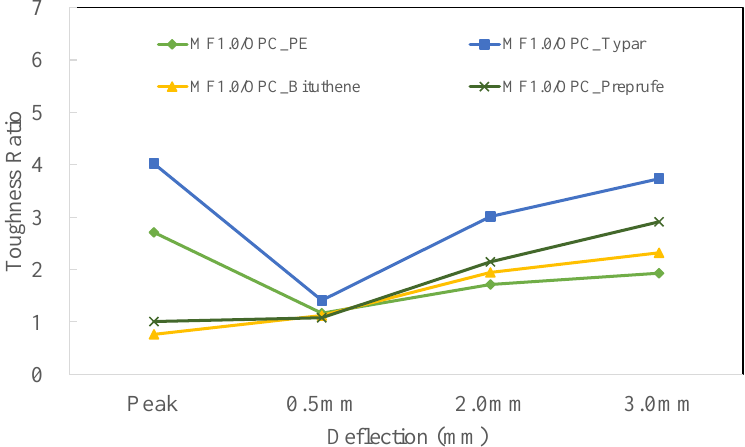
Figure 10. Toughness ratio between MF1.0 and OPC with waterproof reinforcement.